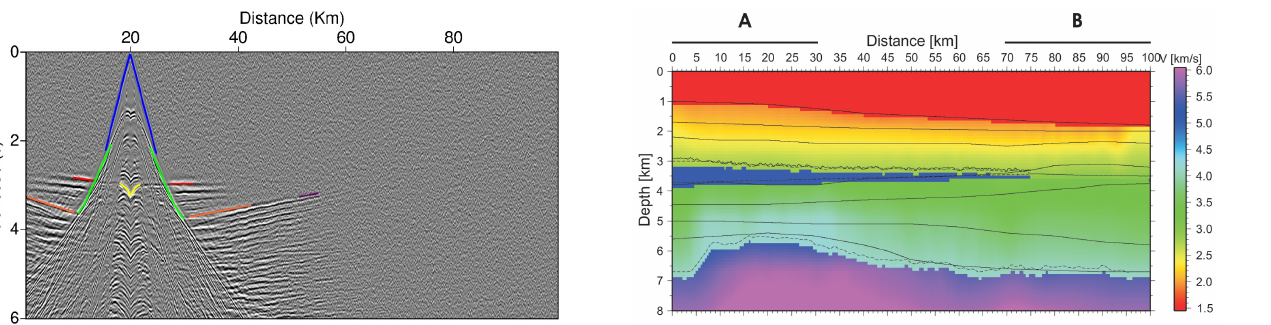
Fig. 6. Synthetic shotgather with noise. Different phases can be identified: water wave (blue), refraction from sediments over the basalt layer (green), refraction from basalt (red), reflection from the top of the basalt (yellow), refractions from basement (purple) and reflections from the top of the basement (orange). Note the differ- ence with Fig. 2 in the refractions from basalt (red).